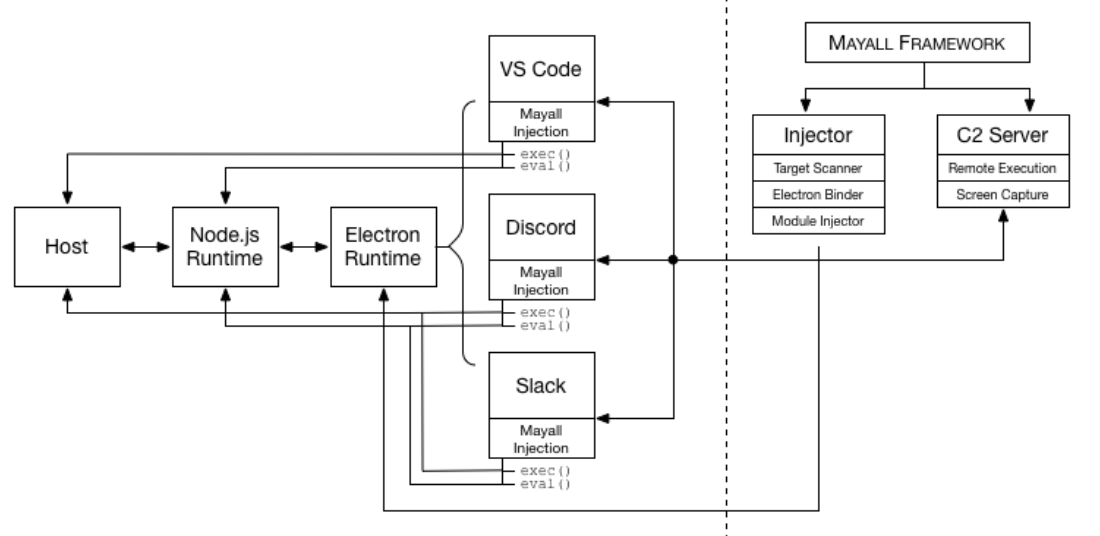
Figure 5. Framework flow between the infected system and command and control server running under